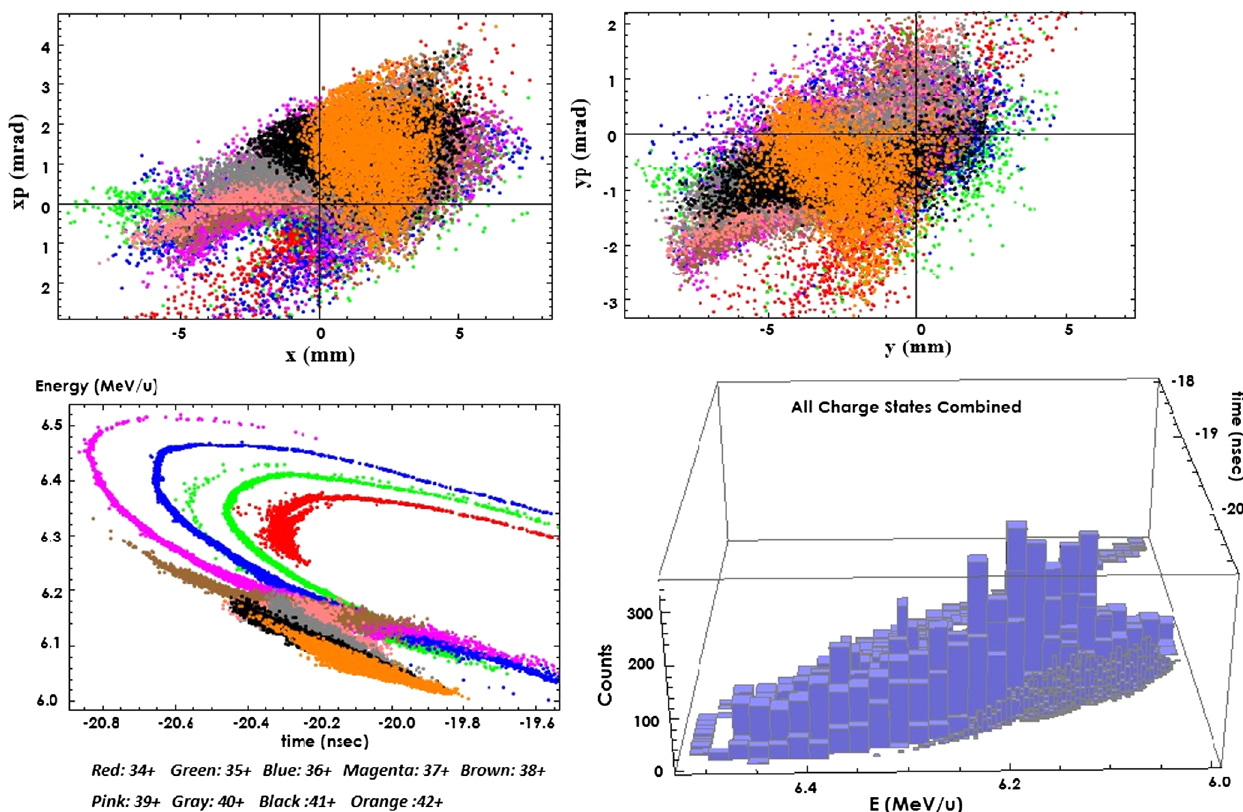
FIG. 6. Final distribution of nine charge states from 34 þ to 42 þ accelerated to 6 . 2 MeV